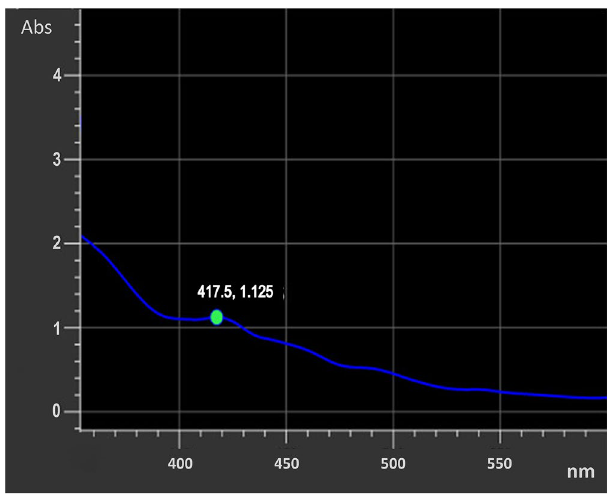
Figure 1. UV–Vis absorption spectra of synthesized AgNPs from E. roxburghii leaf extract.